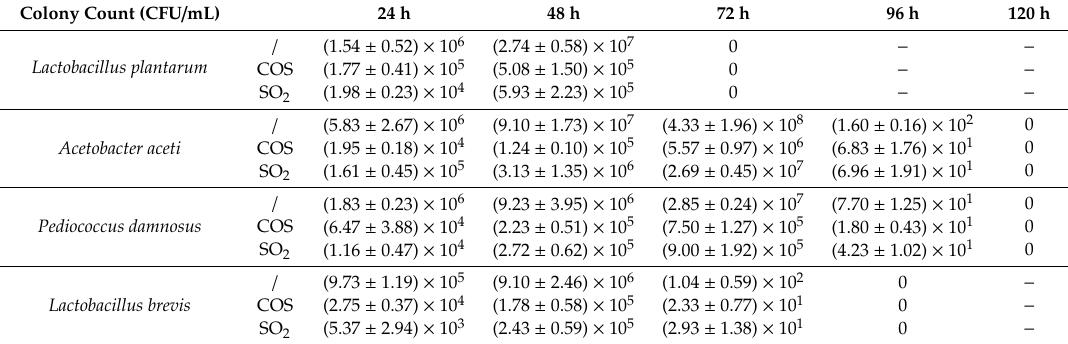
Table 4. The colony counts of four known wine spoilage organisms at each time point (24, 48, 72, 96, and 120h) after using 500 mg / L COS or 100 mg / L SO 2 as an